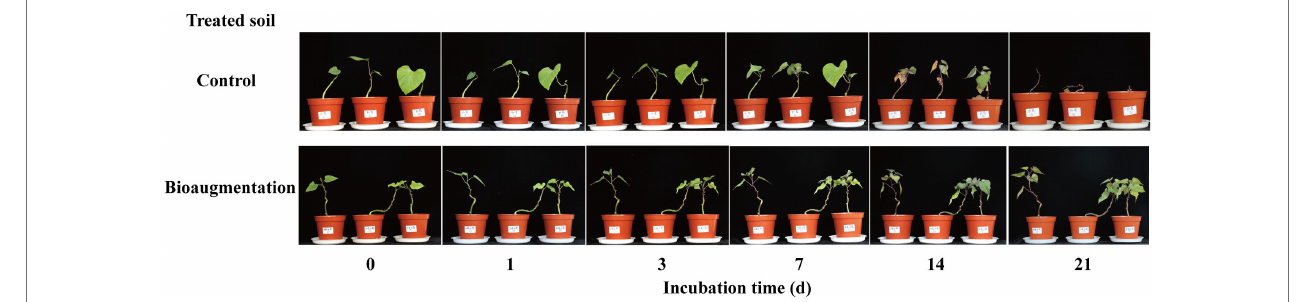
FIGURE 2 | The phytotoxicity of atrazine on sweet potato seedlings alleviated by bioaugmentation. Control: native soil spiked with atrazine after incubated 14 days, and the concentration of atrazine remaining in the control soil was 3.36 ± 0.62 mg kg − 1 . Bioaugmentation: atrazine-spiked soil with inoculation of strain AT-5 after incubated 14 days, and the concentration of atrazine remaining in the bioaugmentation soil was 0.09 ± 0.002 mg kg − 1 . Three replicates were set for each treatment.